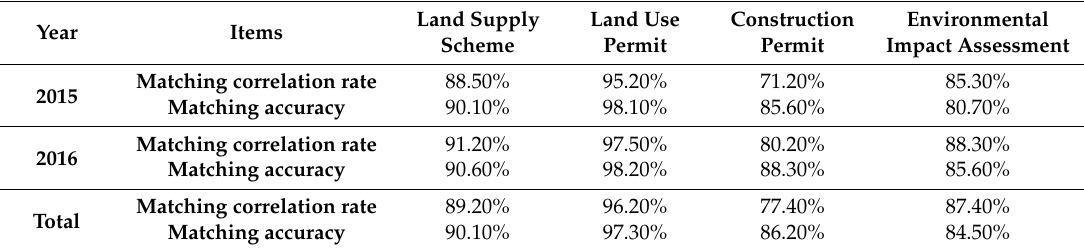
Table 8. The resulting general degrees of correlation for typical approval items.